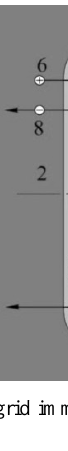
Fig. 1. Schematic of broad electron and fast atom beams